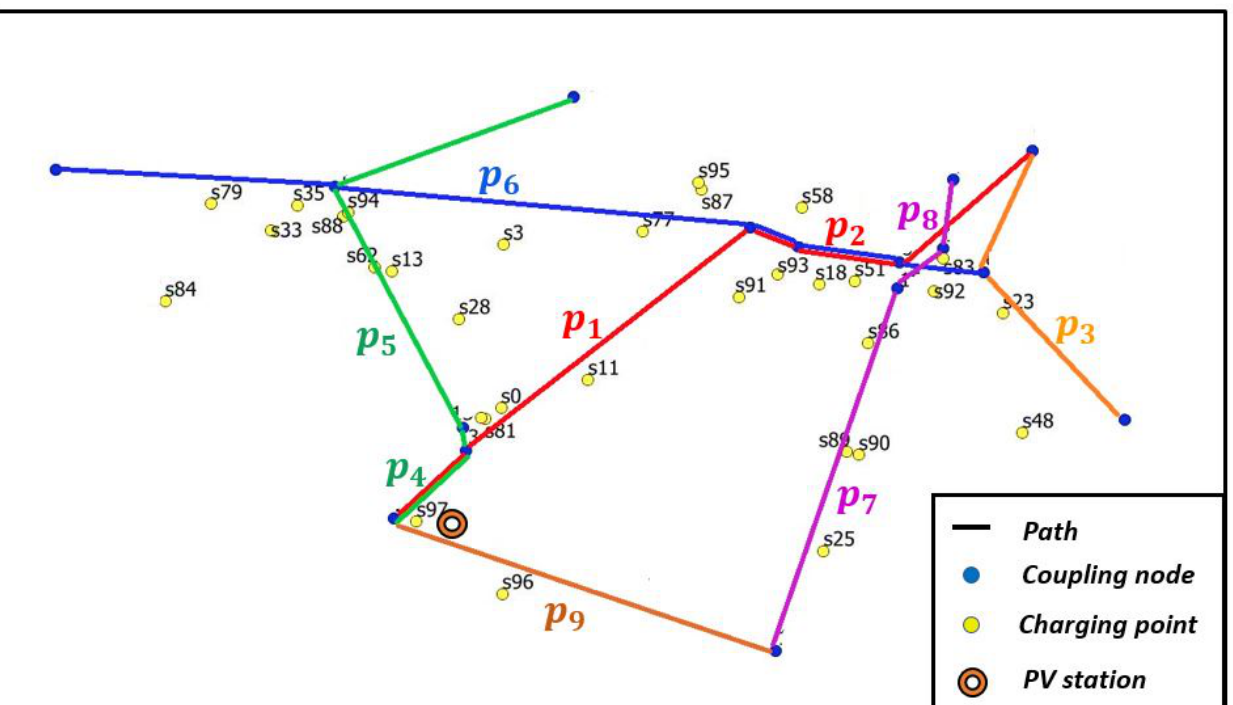
Figure 5. Paris-Saclay: Mobility paths and charging